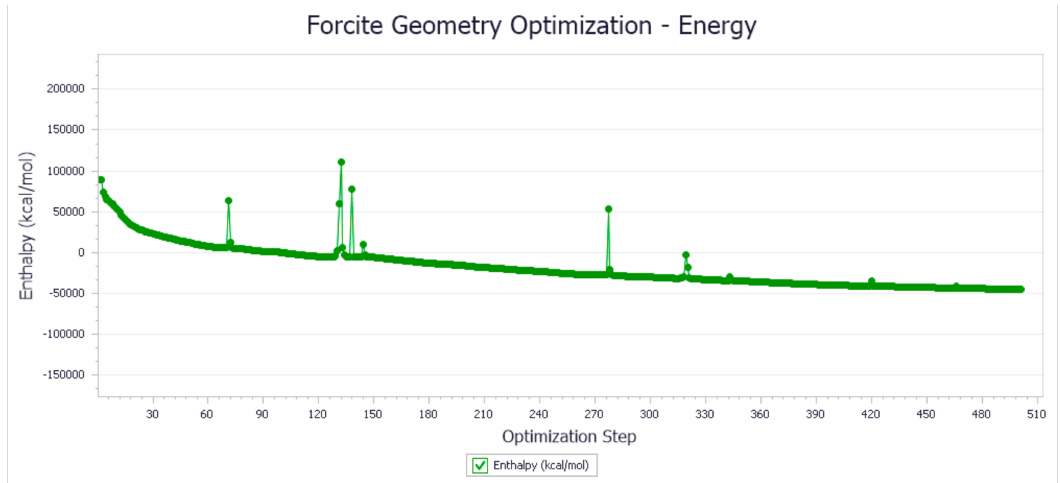
Figure 8. Demulsifier4 # oil–water interface geometry optimization energy trend.